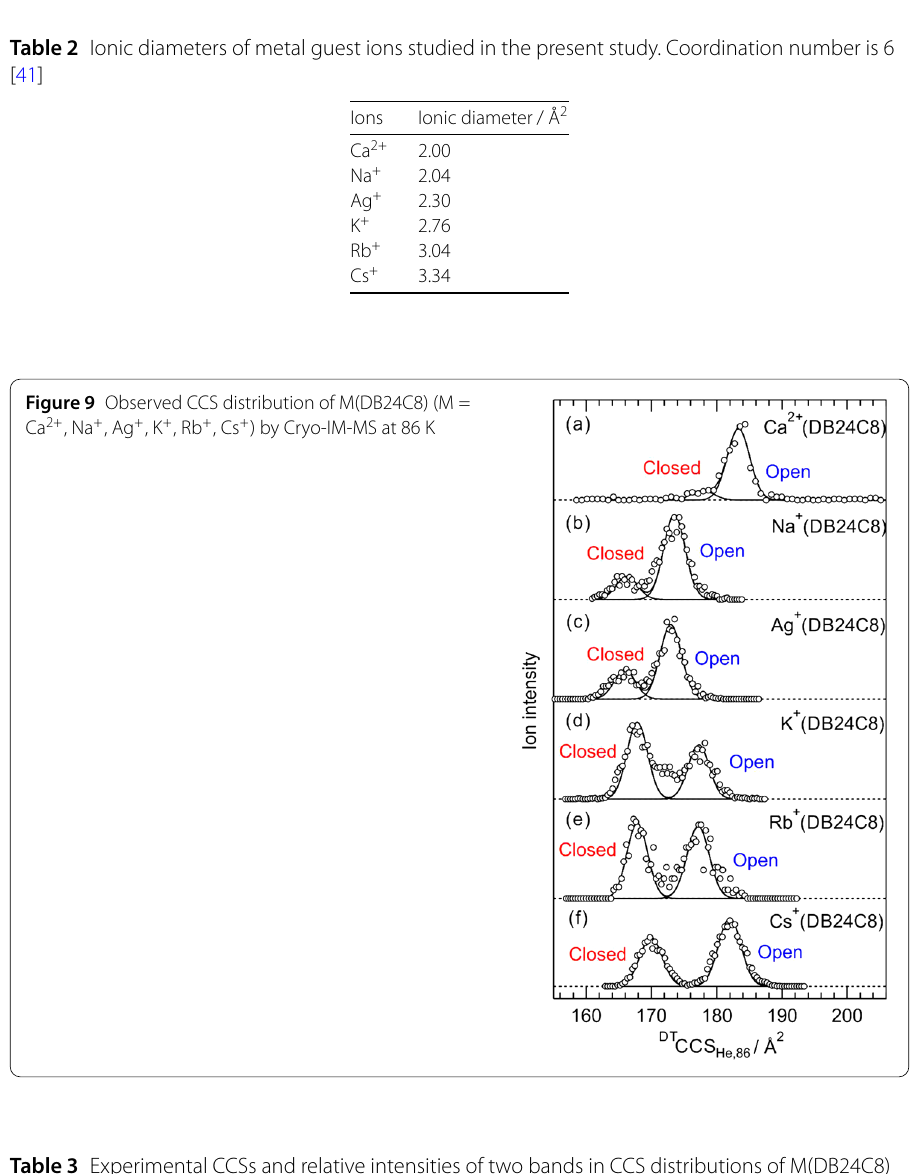
Table 3 Experimental CCSs and relative intensities of two bands in CCS distributions of M(DB24C8) (M = Ca 2+ , Na + , Ag + , K + , Rb + , Cs + ) at T BG = 86 K, and theoretical CCSs and relative Gibbs energies at T BG = 86 K ( (cid:4) G 86 ) of the most stable closed and open conformers Complex Experiment Theory CCS / Å 2 Relative